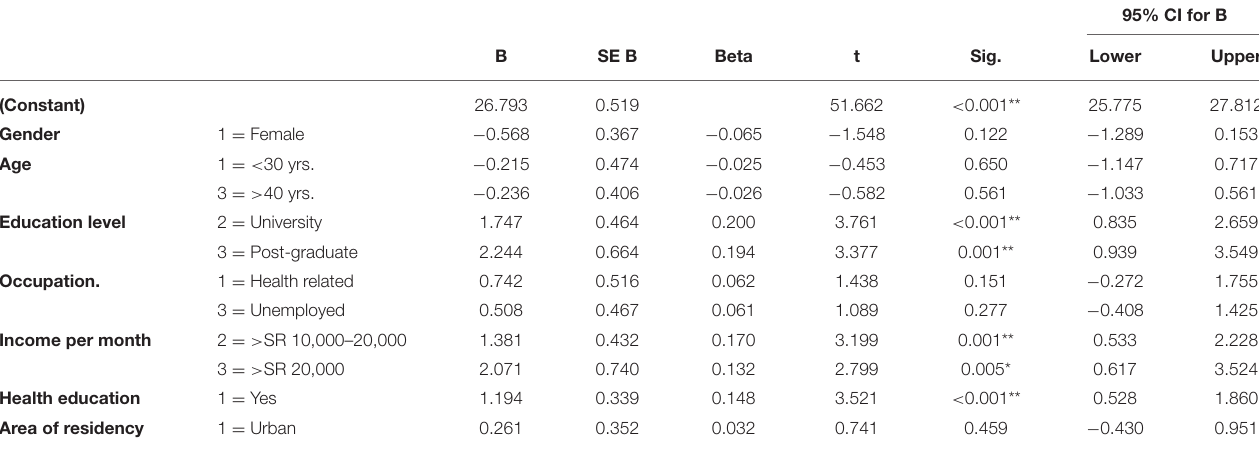
TABLE 3 | Standard multiple regression analysis of COVID-19 knowledge and demographic predictors.